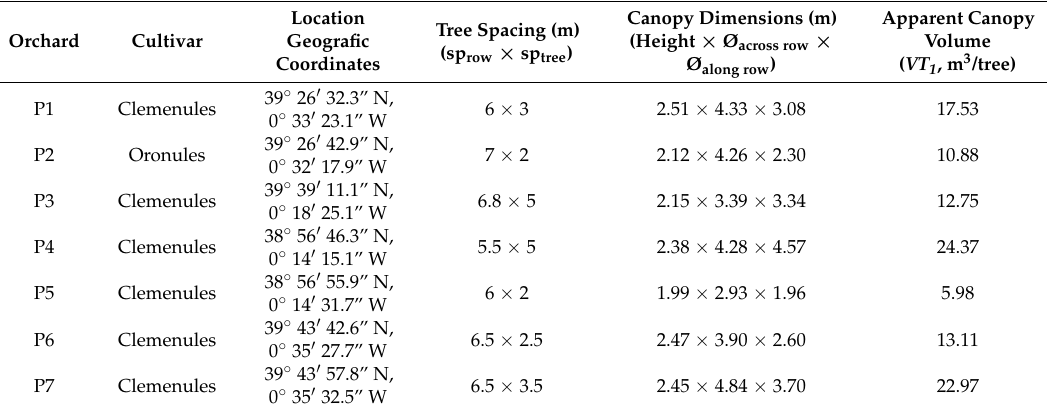
Table 3. Characteristics of trial orchards.